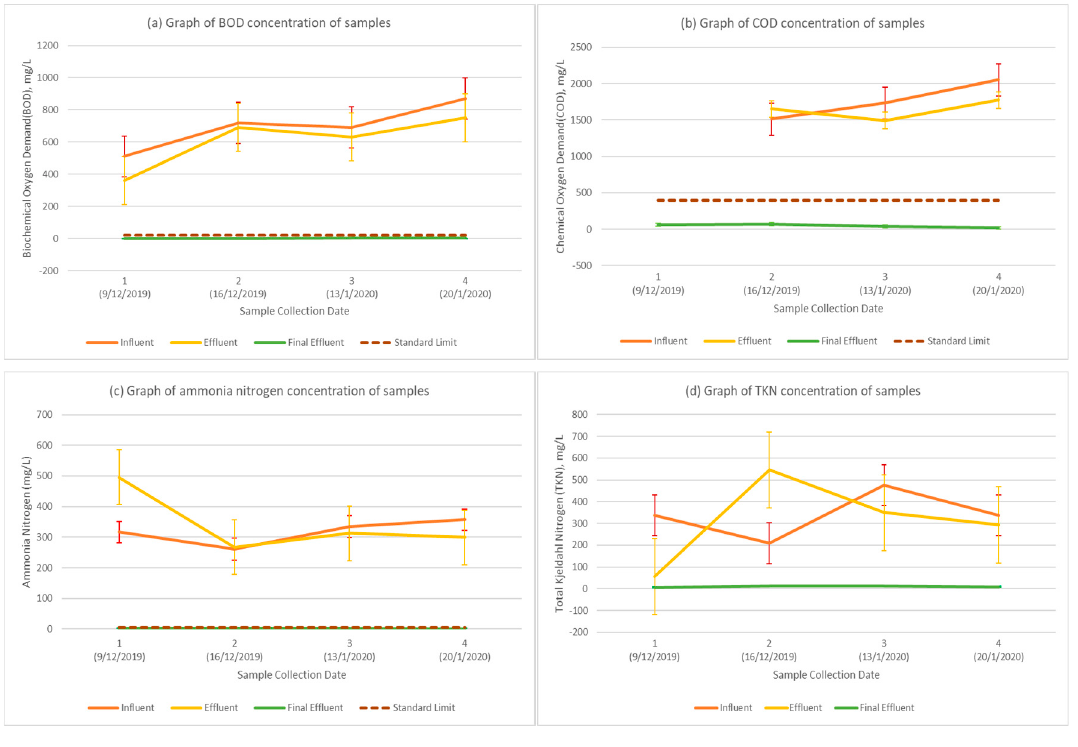
Figure 6. Graph of concentration in ( a ) BOD, ( b ) COD, ( c ) ammonia nitrogen, ( d ) TKN.